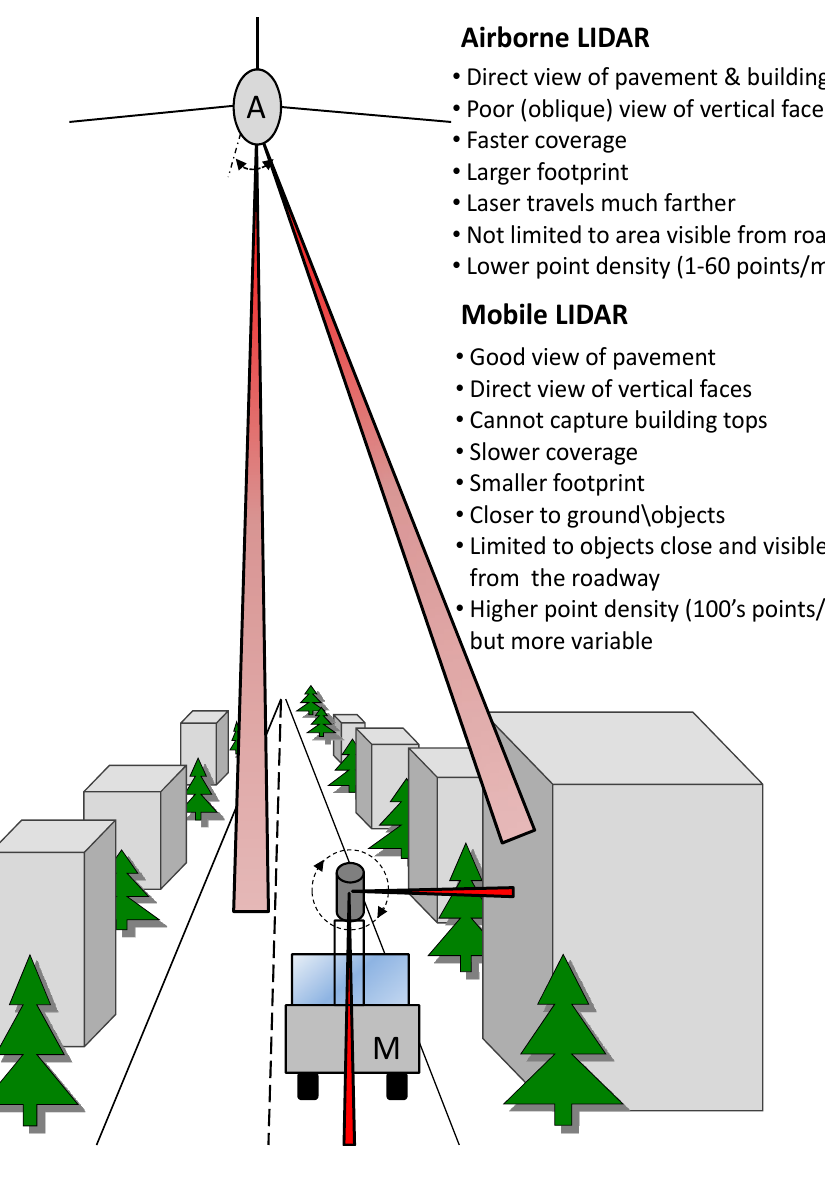
Figure 5. Comparison of airborne and mobile LIDAR